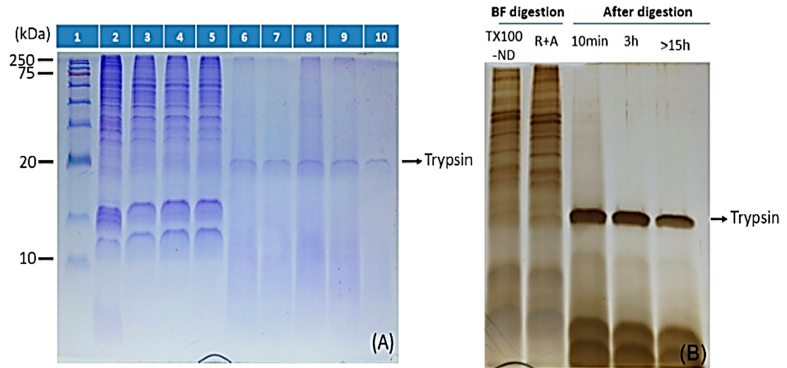
Figure 6. Membrane proteome sample preparation from mammalian cellular membranes by TX-100 salt-induced cloud point extraction coupled with the SPEED platform. Two mammalian cell lines, ( A ) HeLa cells; and ( B ) mouse myeloma cells, were demonstrated for the effectiveness of the method. ( A ) Protein ladders with known molecular weights and a direct input of HeLa cell’s membrane-enriched fraction were loaded in wells 1 and 2, respectively, for reference. Lane 3 presented hydrophobic proteins extracted by SPEED from TX-100 detergent phase; and lane 4 proteins retained after protein reduction and alkylation on ND-surface, but prior to addition of trypsin. Lanes 5–10 monitored the progress of ND-surface enhanced protein digestion: lane 5 overnight without trypsin (a duplicate of lane 4), lanes 6–10 with trypsin/protein ~1/50 and sampled at a digestion time of 10 min, 30 min, 1 h, 3 h, and overnight, respectively; ( B ) BF, TX-100-ND, and R + A stand for before digestion, ND pellet collected in protein extraction from TX-100 detergent-rich phase, and upon completion of reduction/alkylation of proteins on ND-surface, respectively. Where ND was present, proteins/peptides were eluted with 3% SDS loading buffer and only the supernatant was loaded for SDS-PAGE analyses.